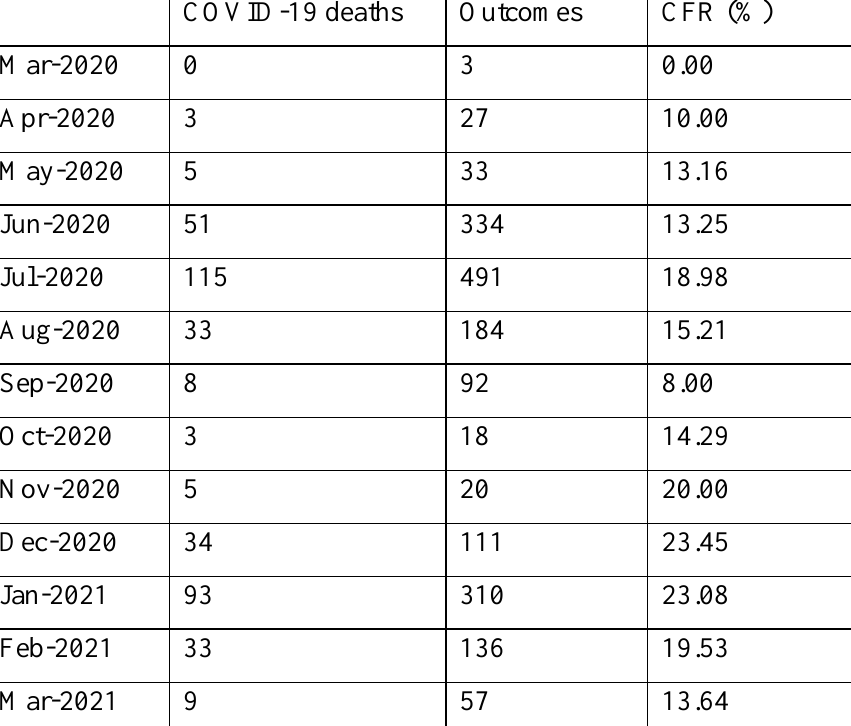
Table 2. COVID-19 in-hospital monthly case fatality ratio at Charlotte Maxeke Hospital, March 2020 - March